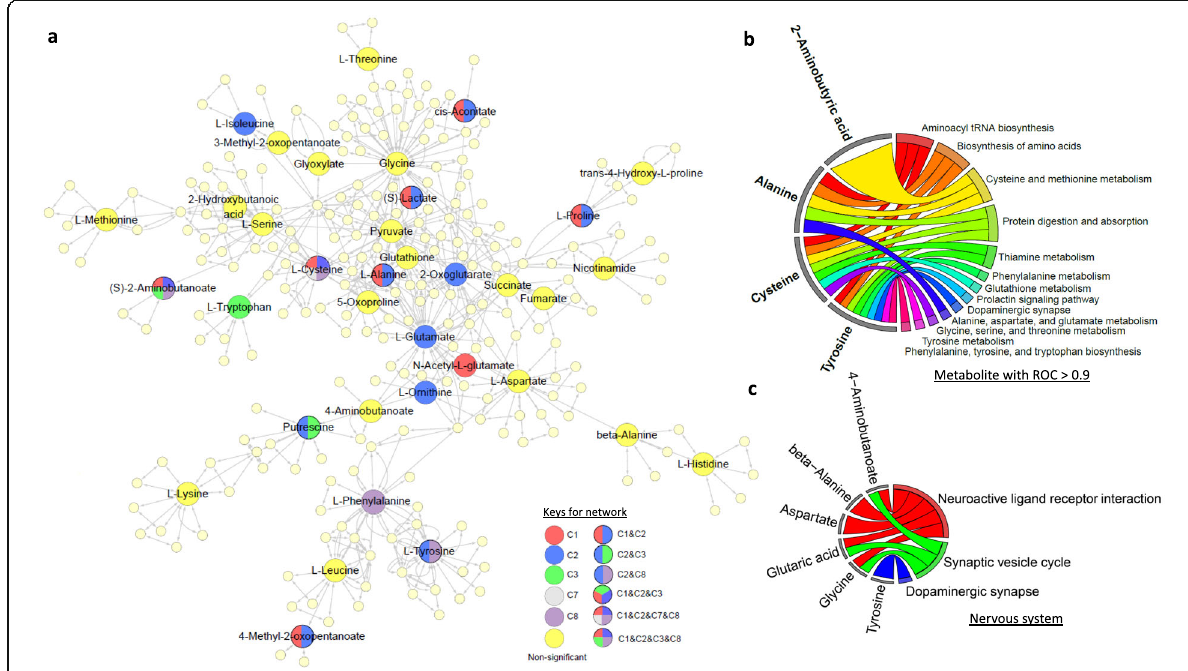
Fig. 8 The metabolic networks represented in the hair metabolome of MCDA twins. a The two-dimensional network was constructed using the metabolic pathways that were significantly different between the different sIUGR clinical forms and control twins. The red circles are metabolites that were significantly different between T2&T3 sIUGR-S and Control abbreviated as C1. The blue circles are metabolites that were significantly different between T2&T3 sIUGR-L and Control abbreviated as C2. The green circles are metabolites that were significantly different between T2&T3 sIUGR-S and T1 sIUGR-S abbreviated as C3. The grey circles are metabolites that were significantly different between T1 sIUGR-S and Control abbreviated as C7. The purple circles are metabolites that were significantly different between T1 sIUGR-L and Control abbreviated as C8. Metabolites present in multiple comparisons are merged with multiple colors. The yellow circles are identified metabolites that exhibited no statistical significance. All smaller yellow circles are unidentified metabolites that were directly linked to identified metabolites. The arrowheads indicate the direction of the metabolic reactions. b A chord plot displays how metabolites with ROC curve > 0.9 participate in different significant metabolic pathways. c A chord plot displays how metabolites involved in the nervous system link to metabolic